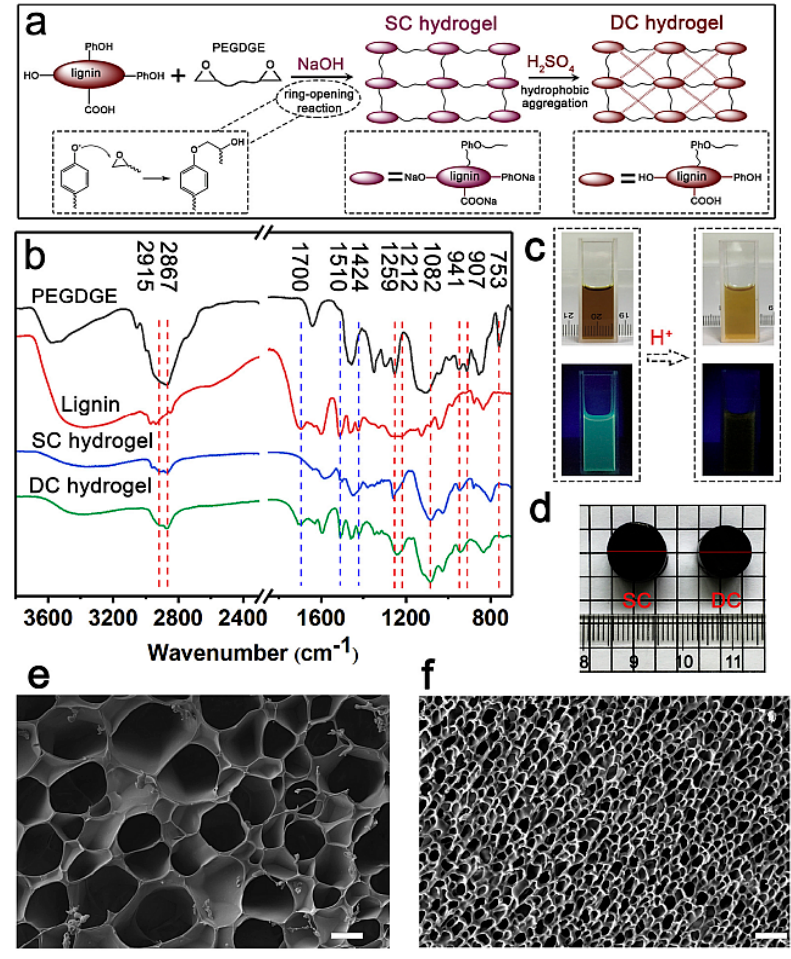
Figure 11. ( a ) Schematic representation of double-crosslinking reaction of DC lignin hydrogel through chemical crosslinking polymerization, followed by physical hydrophobic aggregation crosslinking. ( b ) FTIR spectra of poly(ethylene glycol) diglycidyl ether (PEGDGE), lignin, and the single-network (SC lignin hydrogel) and double-network (DC lignin hydrogel) lignin hydrogels. ( c ) Photographs of lignin in NaOH solution before and after treatment with H 2 SO 4 : (top) bright field images; (bottom) irradiated at 365 nm. ( d ) Photographs of the SC and DC lignin hydrogels. ( e , f ) SEM images of the ( e ) SC and ( f ) DC lignin hydrogels; scale bars: 20 µ m. Reprinted with permission from ref. [86]. Copyright 2020